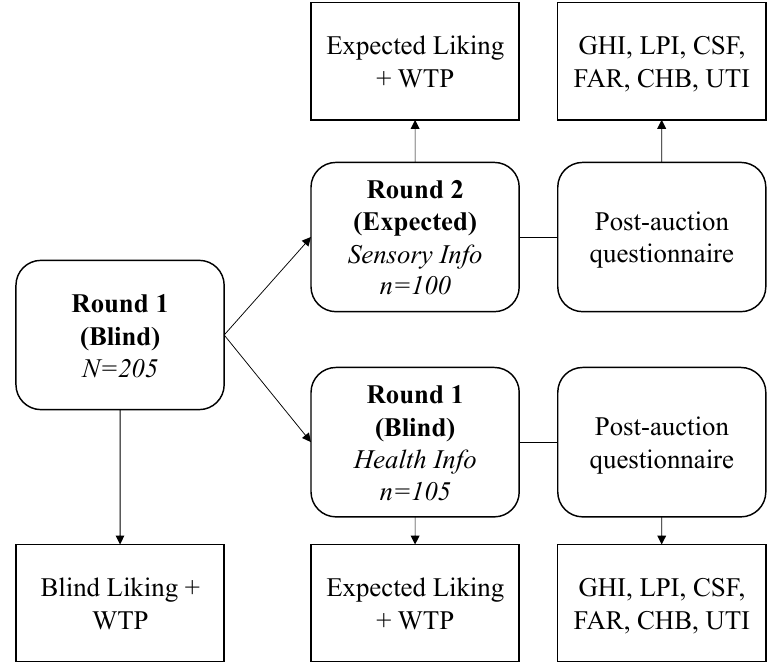
Figure 1. Experimental design. WTP (willingness-to-pay), GHI (General Health Interest), LPI (Light Product Interest), CSF (Craving for Sweet Foods), FAR (Food as A Reward), CHB (Compensatory Health Beliefs), UTI (Unhealthy=Tasty Intuition).